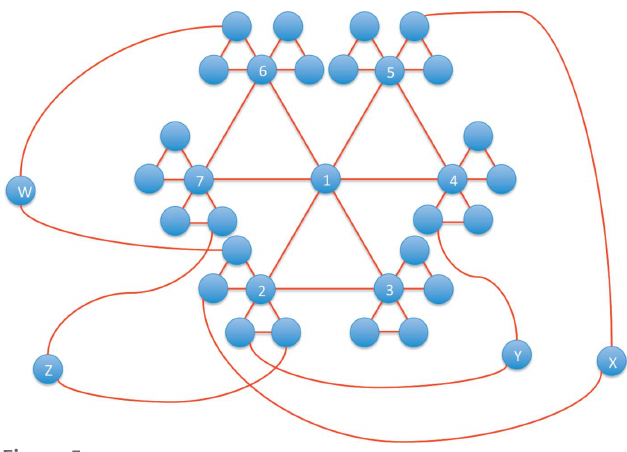
Figure 5 The deformation pathway graph for an f.c.c. crystal.